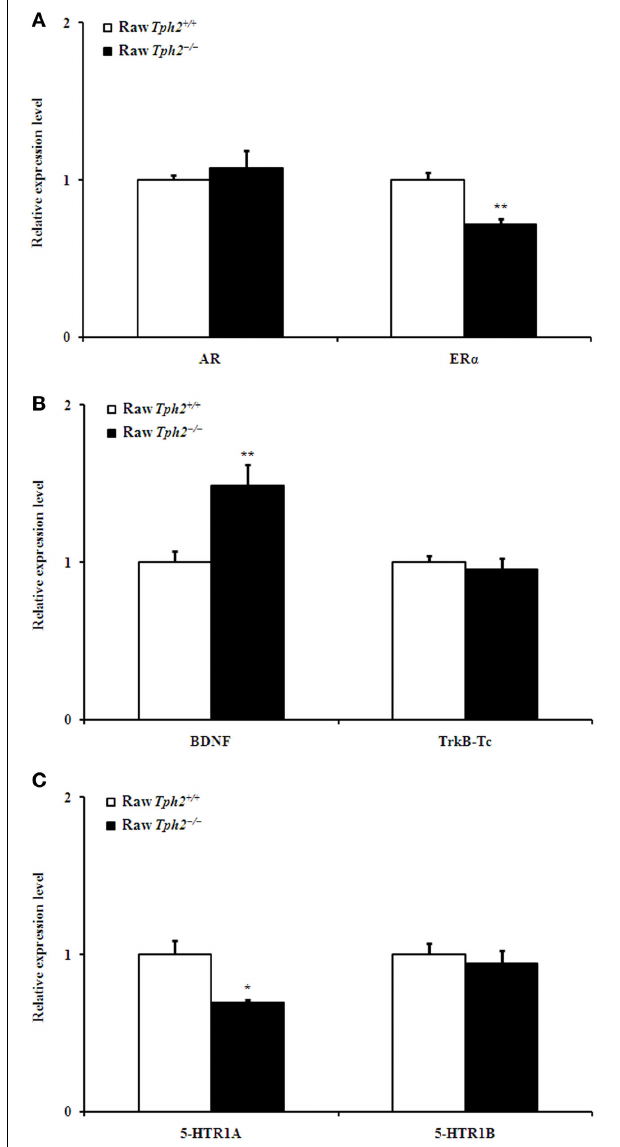
FIGURE 6 | Comparison of the relative expression of AR and ER α (A), BDNF and TrkB-Tc (B), and 5-HTR1A and 5-HTR1B (C) in the hippocampus between the raw Tph2 + / + male mice and the raw Tph2 − / − ones (mean ± SE, for the raw Tph2 + / + male mice, n = 8; for the raw Tph2 − / − male mice, n = 6). The data were analyzed by independent-samples t -test ( ∗ P < 0 . 05; ∗∗ p < 0 .